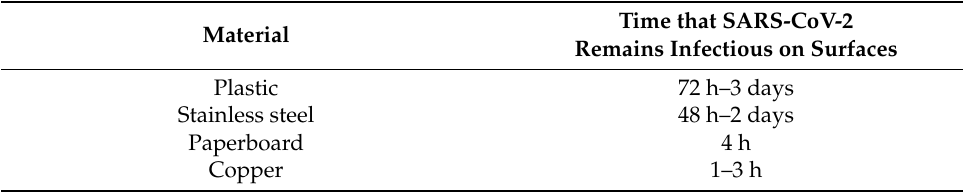
Table 2. SARS-CoV-2 viability in different materials [15].